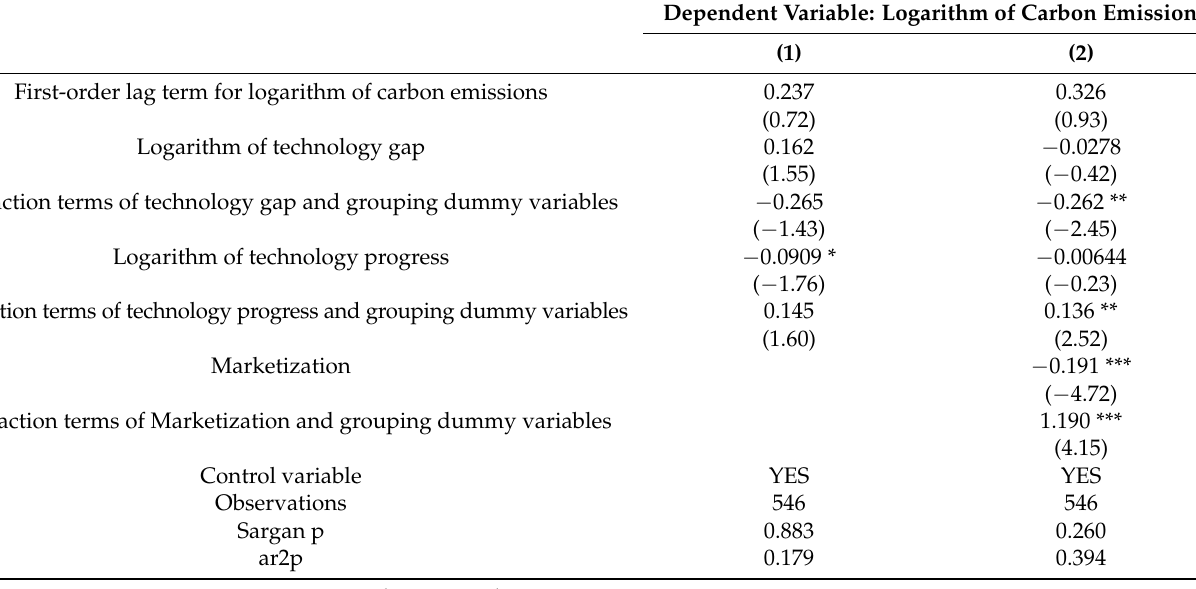
Table 4. Heterogeneity analysis.